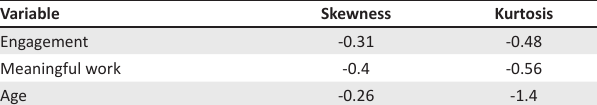
TABLE 3: Skewness and